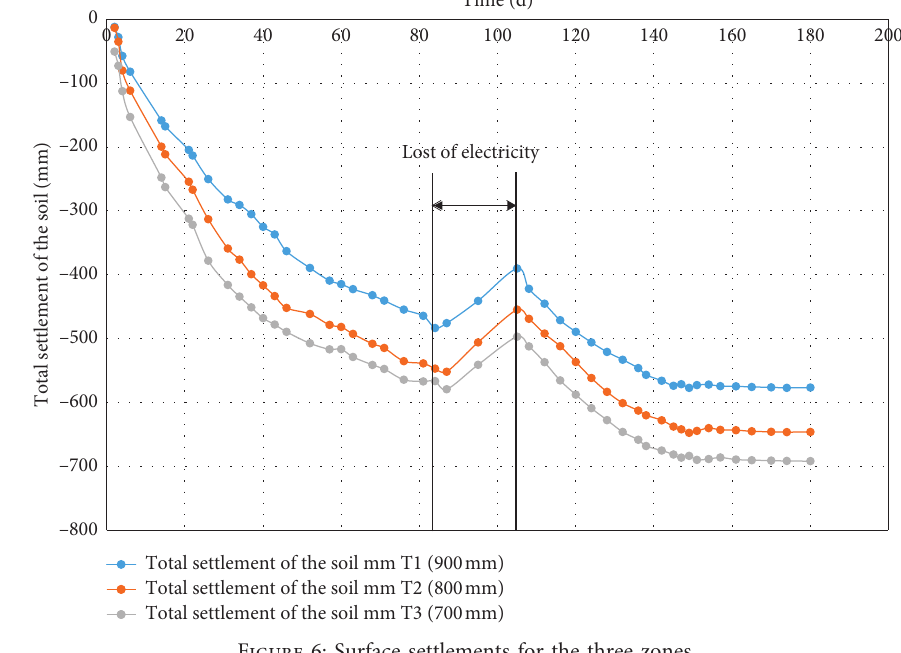
Figure 6: Surface settlements for the three zones.